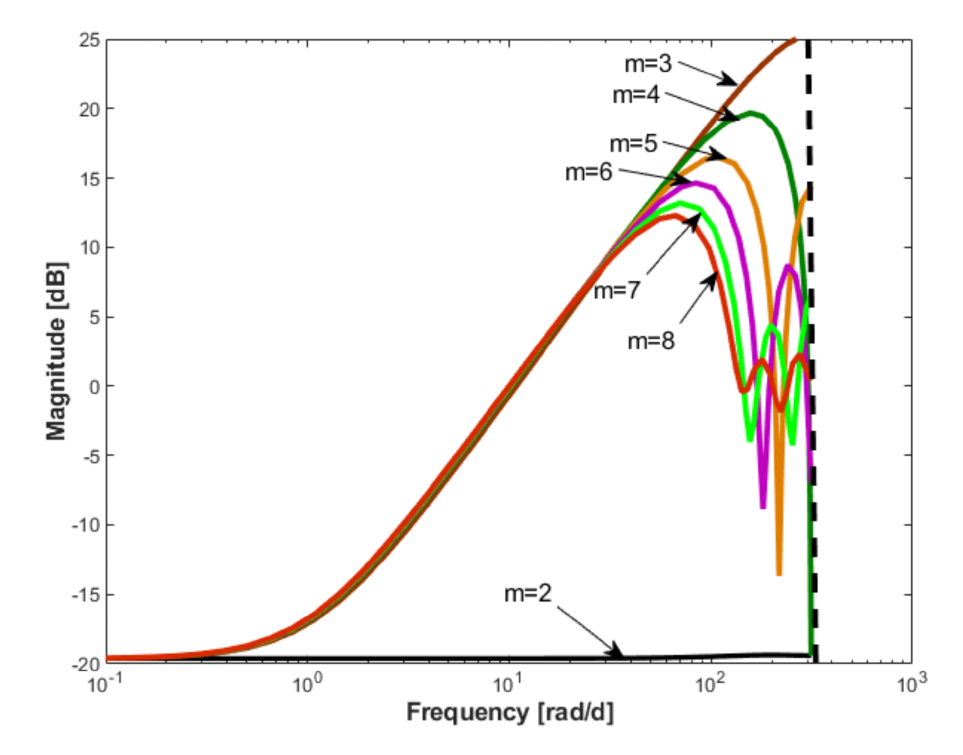
Figure 9. The Bode characteristics of the Q ( z, θ ) for (cid:101) ω = 5 [ rad/d ] and m = 2, . . .